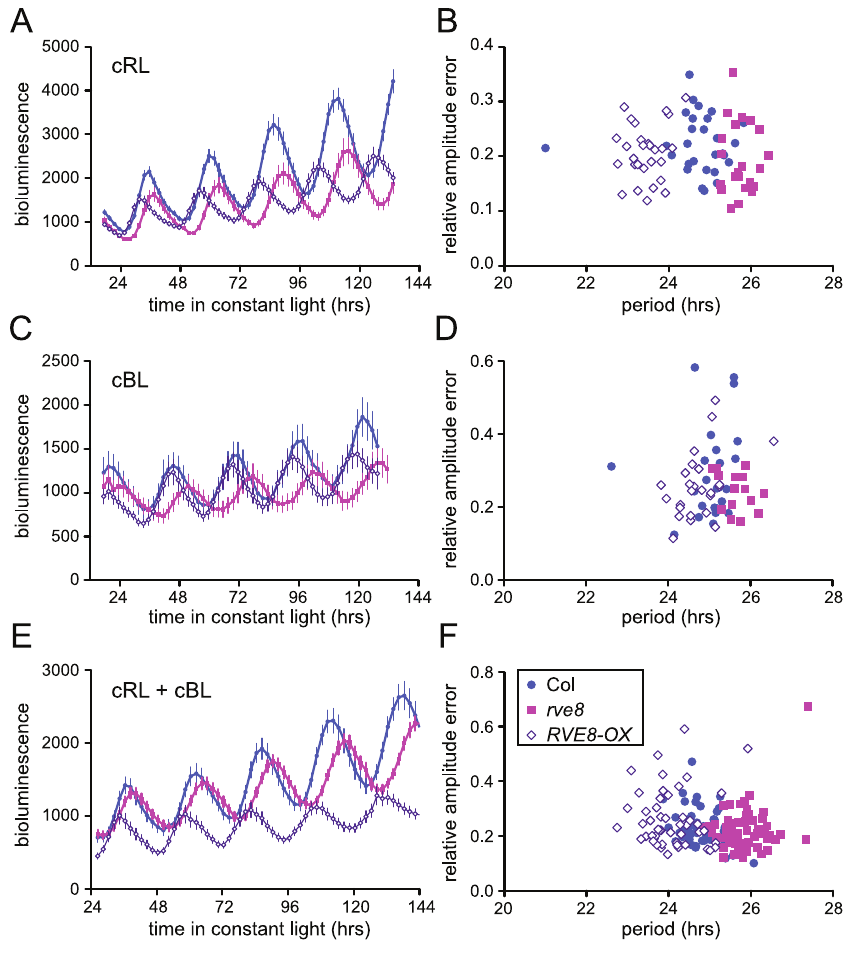
Figure 5. Perturbation of RVE8 expression changes free-running period. Seedlings were entrained in 12 hr light:12 hr dark for 6 days and then transferred to either constant red (44 mol m 2 2 s 2 1 ) (A–B), blue (19 mol m 2 2 s 2 1 ) (C–D), or red + blue (36 mol m 2 2 s 2 1 red and18 mol m 2 2 s 2 1 blue) (E–F) light; CCR2::LUC activity rhythms were then monitored. (A, C, E) Average luciferase activity of Col, rve8-1 , and RVE8-OX plants expressing CCR2::LUC ; each point is the average of 20–25 seedlings and error bars represent 6 SEM. (B, D, F) RAE, a measure of rhythmic robustness (with smaller values indicating stronger rhythms) is plotted relative to free-running period. (A, B) In red light, the free-running periods of rve8-1 and RVE8-OX were significantly different from Col (Col=24.75 6 0.15 hr; rve8-1 =25.73 6 0.07 hr; RVE8-OX =23.44 6 0.07 hr; p , 0.0001 for both comparisons). (C, D) In blue light, rve8-1 had a significantly longer period than Col (Col=24.93 6 0.11 hr; rve8-1 =25.70 6 0.09 hr; p , 0.005); RVE8-OX had a shorter period ( RVE8- OX =24.60 6 0.09 hr) than wild type but this was not statistically significant (p=0.08). (E, F) In red + blue, rve8-1 had a significantly longer period and RVE8-OX had a significantly shorter period than Col (Col=24.84 6 0.07 hr; rve8-1 =25.82 6 0.06 hr; RVE8-OX =24.06 6 0.09 hr; p , .0001 for both; Student’s two-tail heteroscedastic t test used for all comparisons). These data are representative of at least two independent